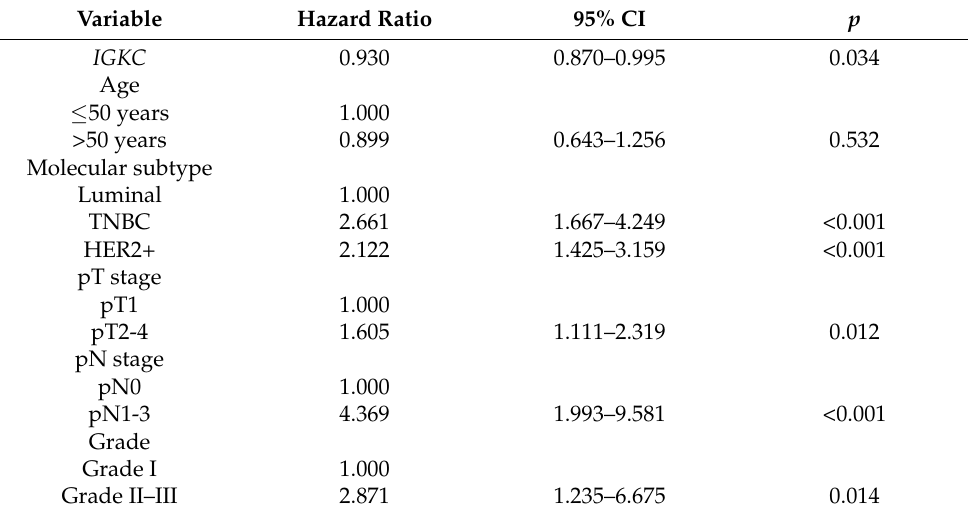
Table 2. Multivariable Cox analysis for DDFS. 868 patients had complete data for all variables and were included in the multivariable analysis. IGKC expression was included as a continuous variable. The results of the univariable analysis are shown in Table S1. CI, confidence interval; IGKC, immunoglobulin kappa C; HER2, human epidermal growth factor receptor 2; TNBC, triple-negative